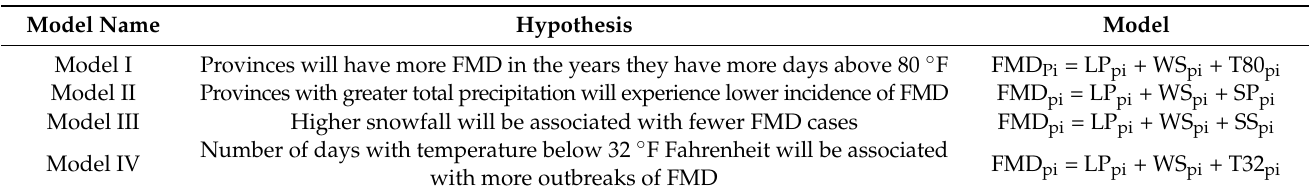
Table 2. Regression models used to analyze the data. (p = province, i = year, LP =